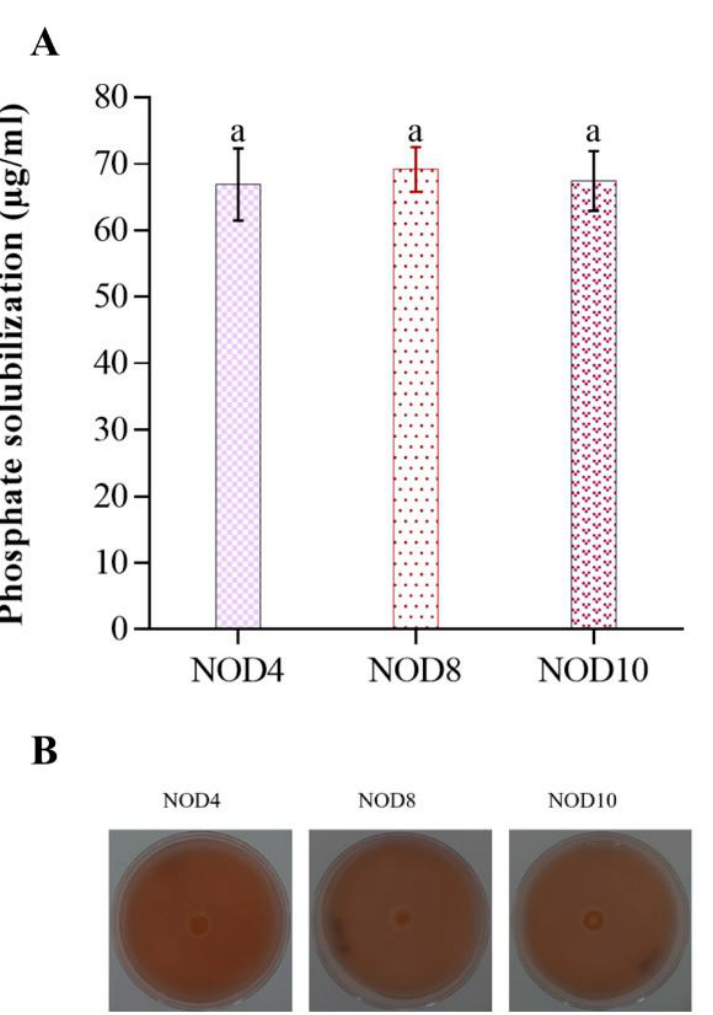
Figure 2. Solubilization of inorganic phosphate by the three strains of Enterobacter . ( A ) Phosphate solubilization ( B ) Pikovskaya PVK.